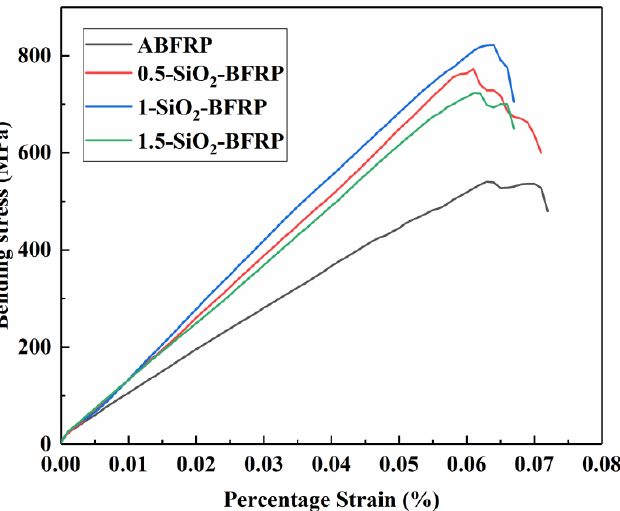
Figure 10. Stress – strain curves of composites treated with different mass fraction of SiO 2 -COOH. Figure 10. Stress–strain curves of composites treated with different mass fraction of SiO 2 Interlaminar Shear Strength